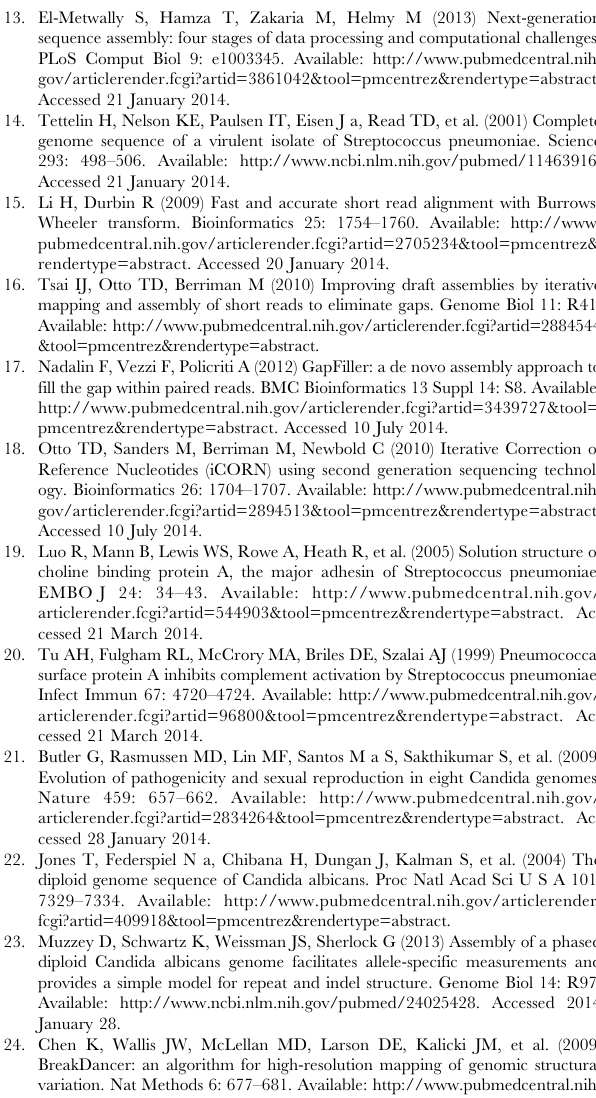
Table S2 Assessment of base corrections by Pilon and iCORN. Table S3 Detailed information regarding the gene based assessment of F11 assemblies. Table S4 Detailed information regarding the gene based assessment of TIGR4. Table S5 Summary of SNP, small in-dels, and large in- dels in M. tuberculosis F11 relative to H37Rv. Table S6 Example SNPs only found with regular Pilon. Table S7 Example IS6110 insertion element variation.